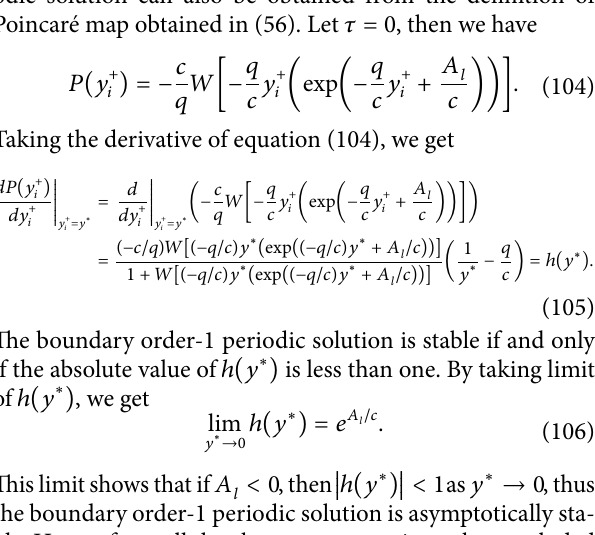
. All other parameter values are fixed as: